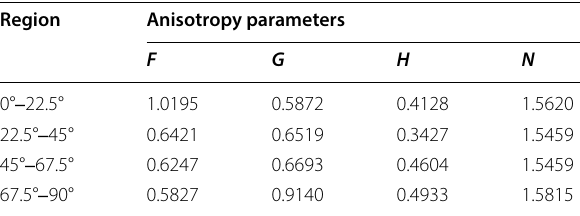
Table 3 Anisotropic parameters of the Hill48